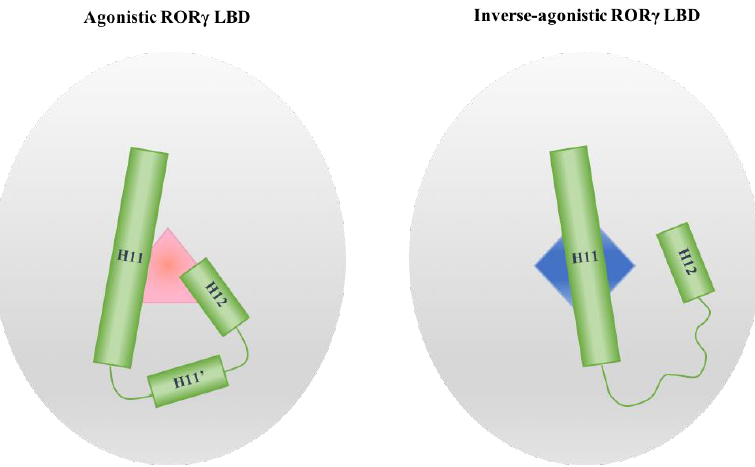
Figure 11. Schematic presentations of the conformational difference of H11, H11′ and H12 in RORγ LBD bound with an agonist (pink triangle) and an inverse agonist (blue diamond).